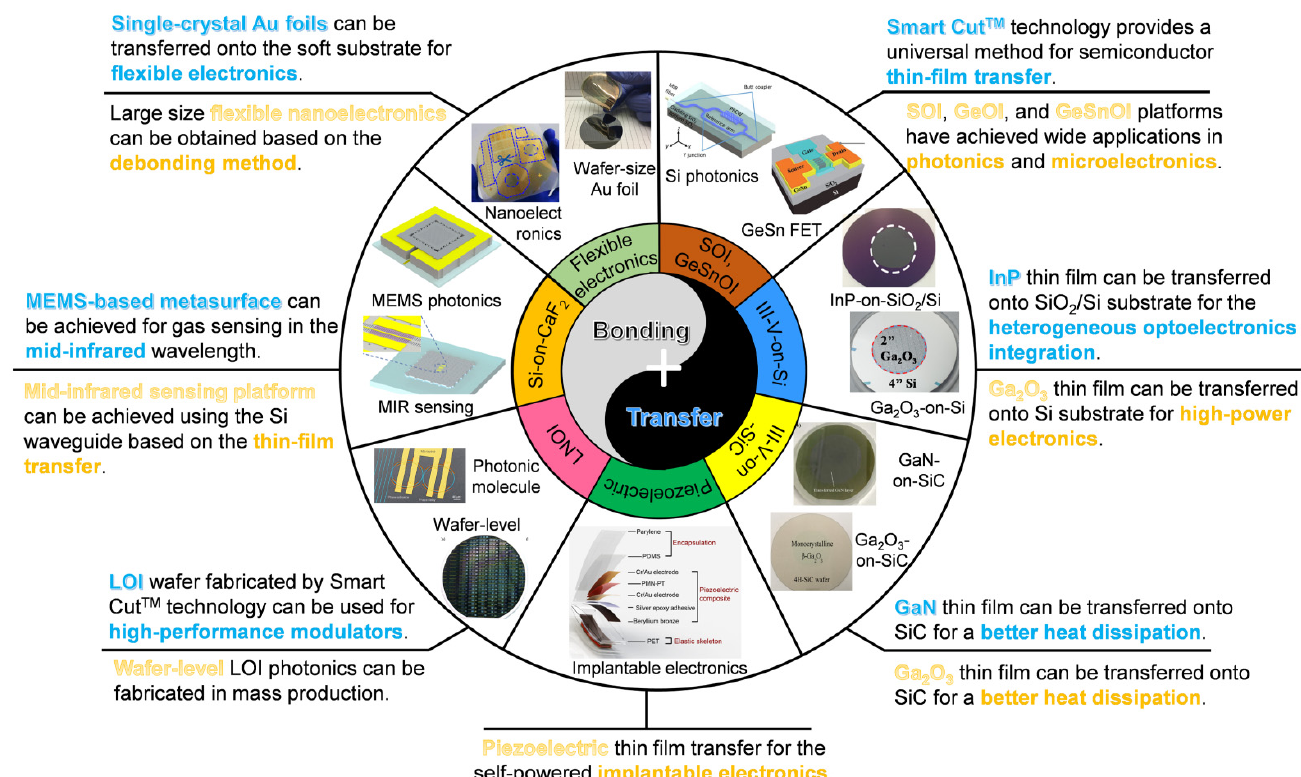
Figure 1. Schematic illustration for the classification of thin-film transfer via bonding methods and their applications in photonics, power electronics, and flexible electronics.